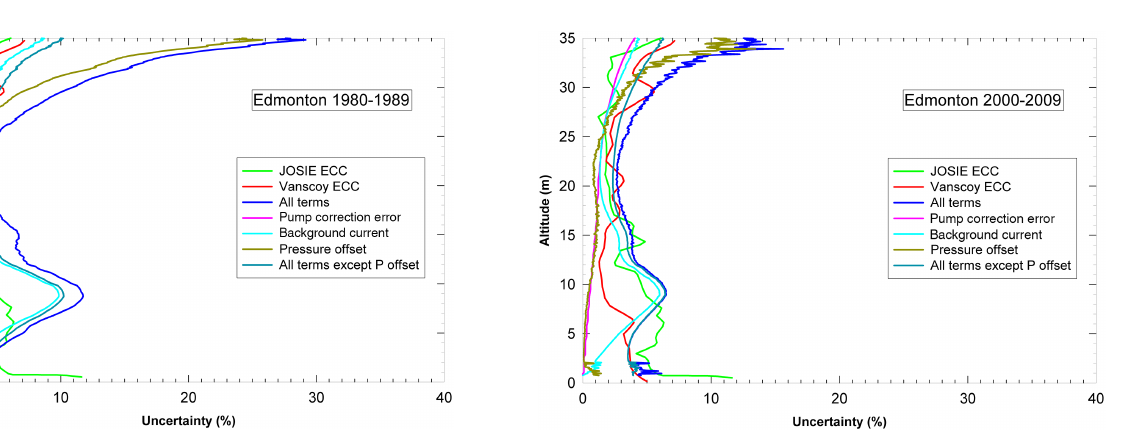
Figure 8. Average estimated uncertainty of ECC (5A and ENSCI) soundings in the 2000s at Edmonton, showing contributions from selected sources. The uncertainty in the RS-80 or (from 2006) RS- 92 radiosonde pressure measurement now dominates the calculated uncertainty only above about